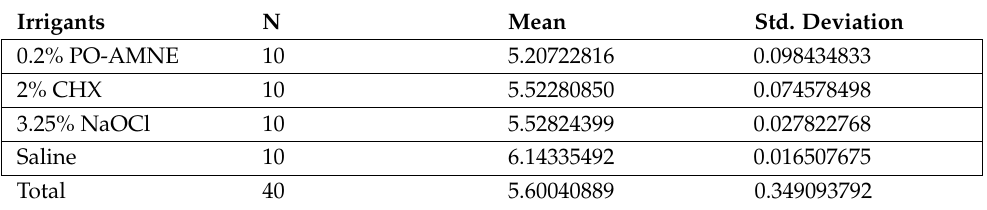
Table 8. Mean and standard deviation of irrigants against E. faecalis at 400 µ m. Irrigants N Mean Std. Deviation